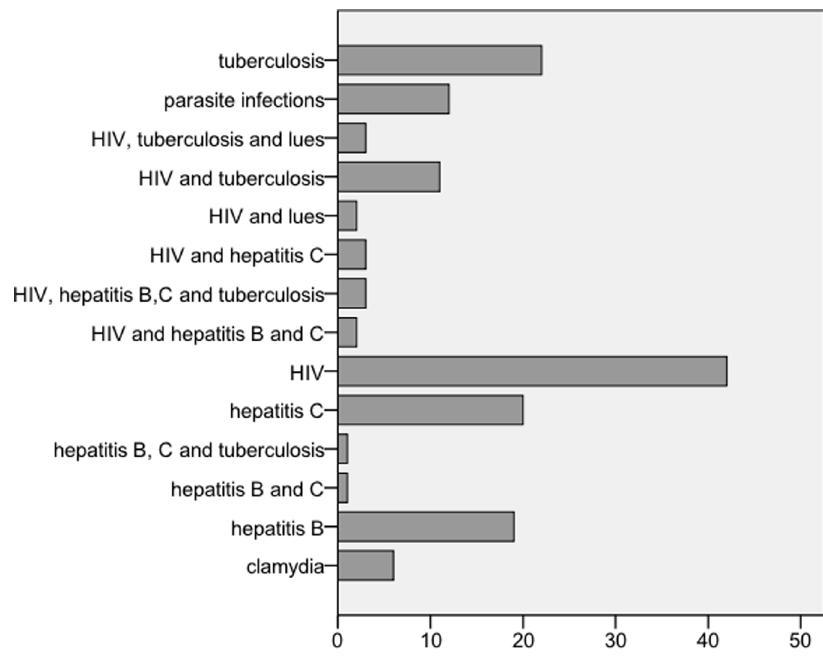
Figure 2. Overview of infectious comorbidities (absolute numbers).